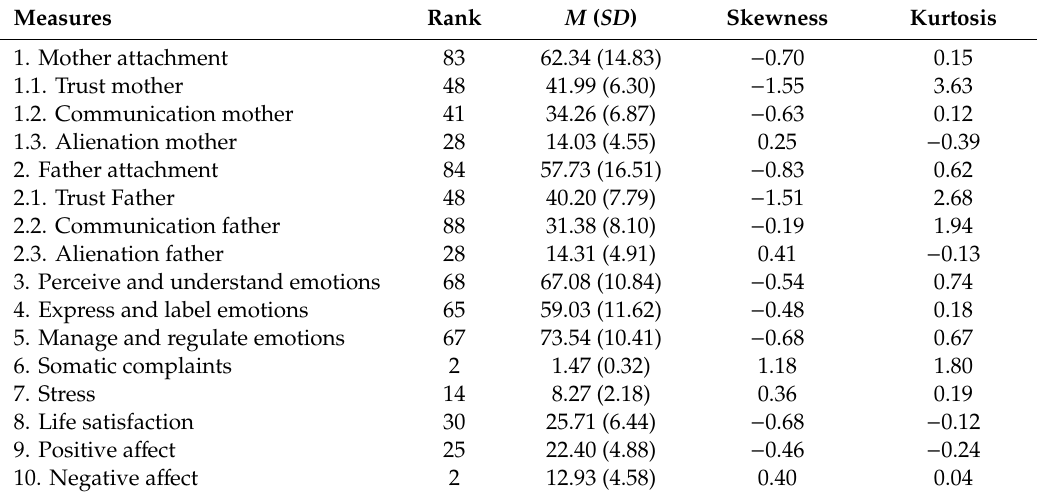
Table 1. Means ( M ), Standard Deviations ( SD ), Range, Skewness and